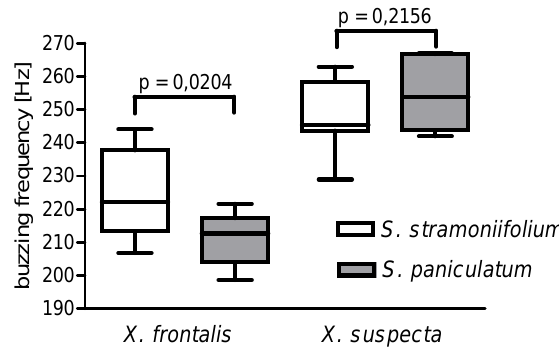
F IG . 3. Box wisker plot showing buzzing frequency of indivudals of Xylocopa frontalis on the flowers of Solanum stramoniifolium (n = 10) and S. paniculatum (n = 8) and of individuals of X. suspecta on the flowers of S. stramoniifolium (n = 12) and S. paniculatum (n = 8).